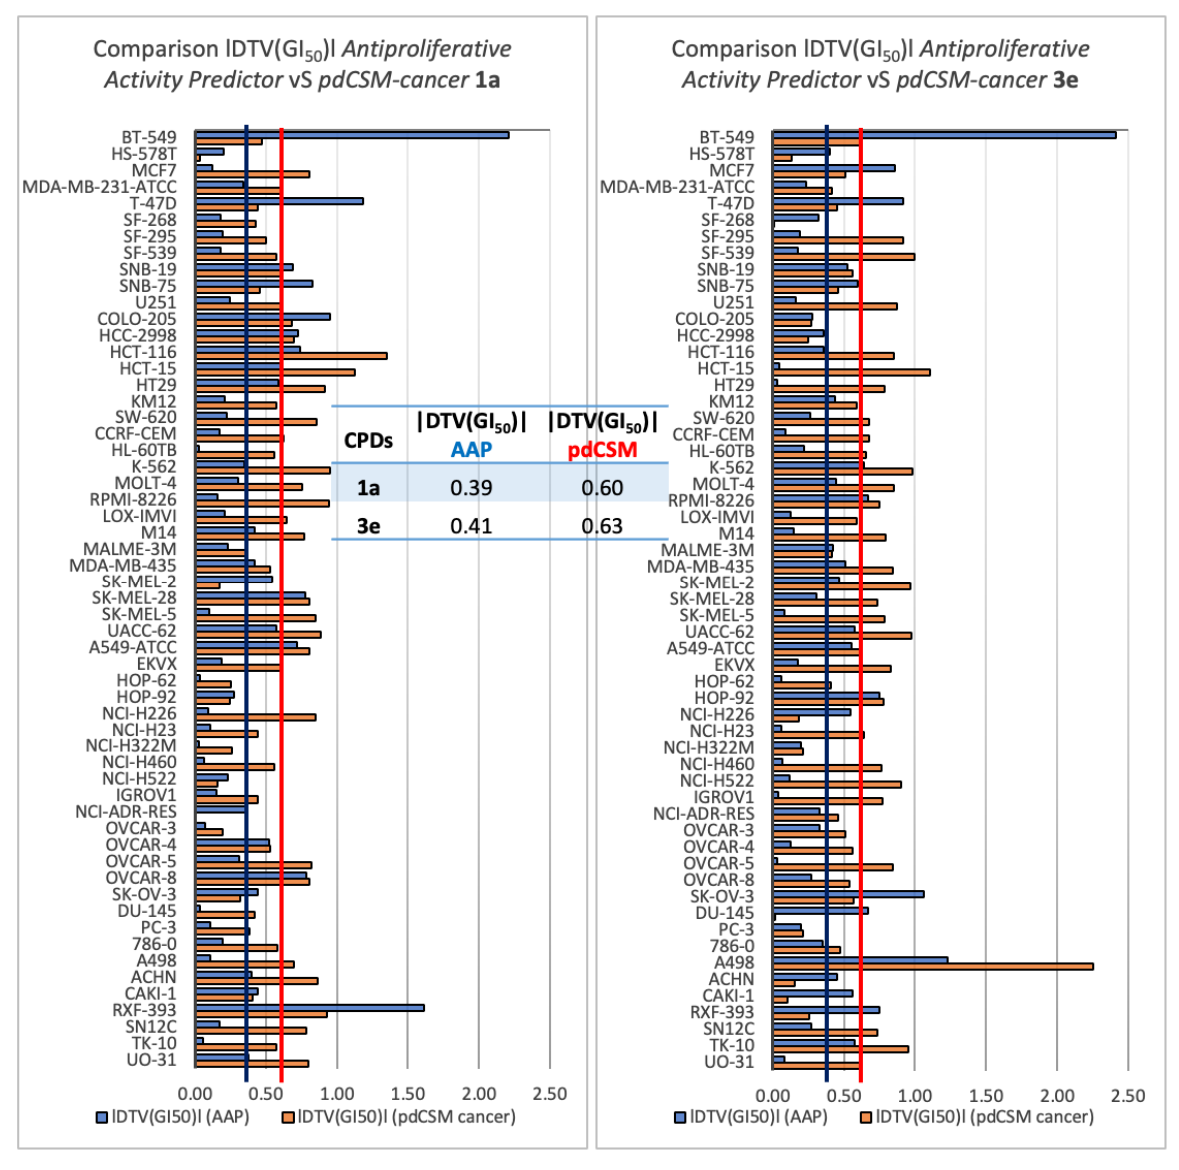
Figure 10. Performance of AAP vs. pdCSM-cancer tools: blue and red vertical lines indicate the |DTV(GI 50 )| for the AAP and pdCSM tools,